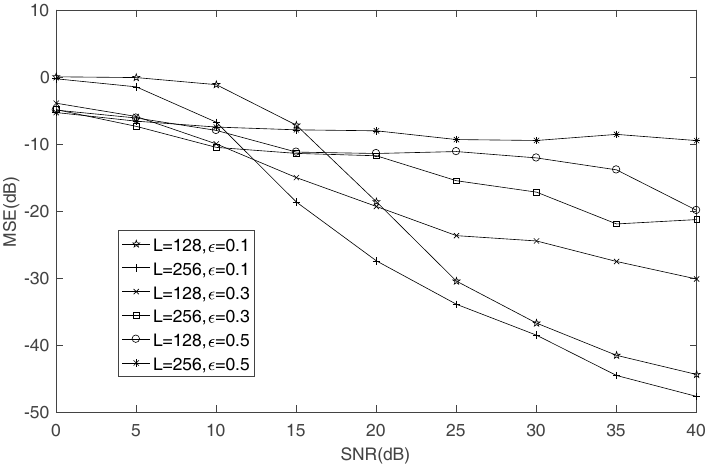
Figure 8. The effect of sample size on the MSE of mixing matrix estimation.